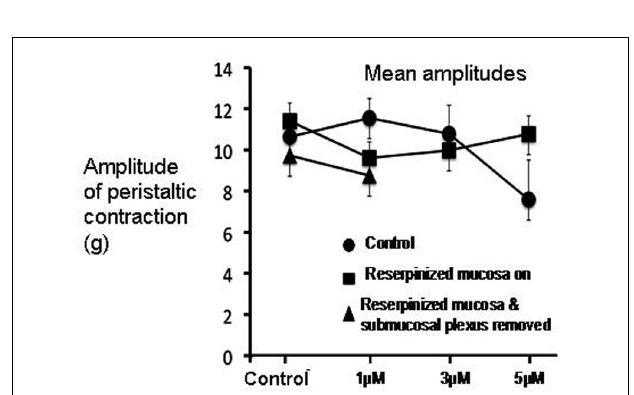
FIGURE 4 | Graph shows mean changes in amplitude of peristaltic contractions, in response to the combined application of ondansetron and SDZ-205-557 in three different experimental groups. In control animals (see filled circles), after an initial blockade of peristaltic contractions by both antagonists, the amplitude of peristaltic contractions recovered to amplitudes that were not significantly different from reserpine-treated animals which had mucosa present (filled squares), or reserpine-treated that were mucosa-free (filled